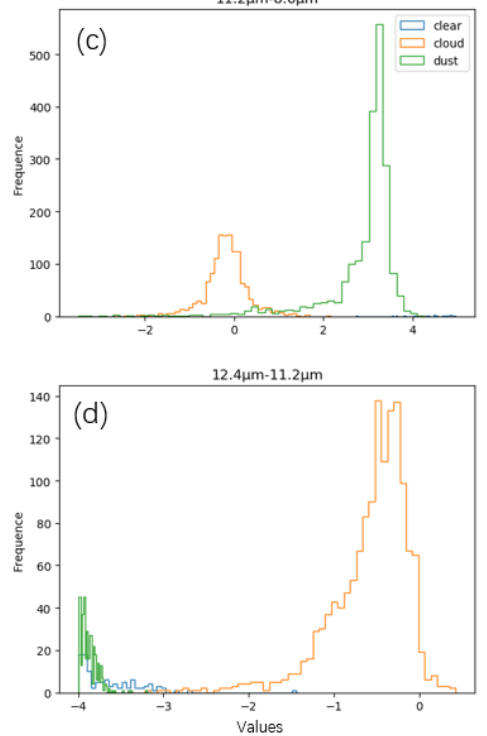
Figure 2 The histogram of the sampled values for over dust loading